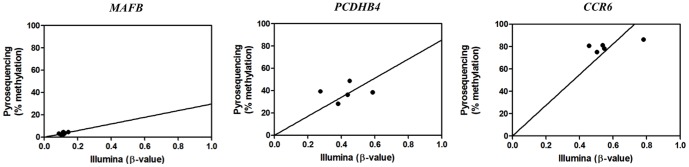
CpG pyrosequencing-based validation of Illumina 450K array results.DNA methylation of blood leukocyte gDNA of 5 volunteers was bisulfite treated and amplified by specific biotinylated primer sets for respectively a highly methylated CpG probe region of the CCR6 gene, a medium methylated CpG probe region of the PCDHB4 gene and a weakly methylated CpG probe region of the MAFB gene. DNA methylation intensities obtained from the different CpG probes by CpG pyrosequencing were plotted against the β-values (0<x<1, reflecting 0–100% DNA methylation) obtained with the Illumina 450K array platform. Curve fitting reveals significant correlation of results between both platforms.